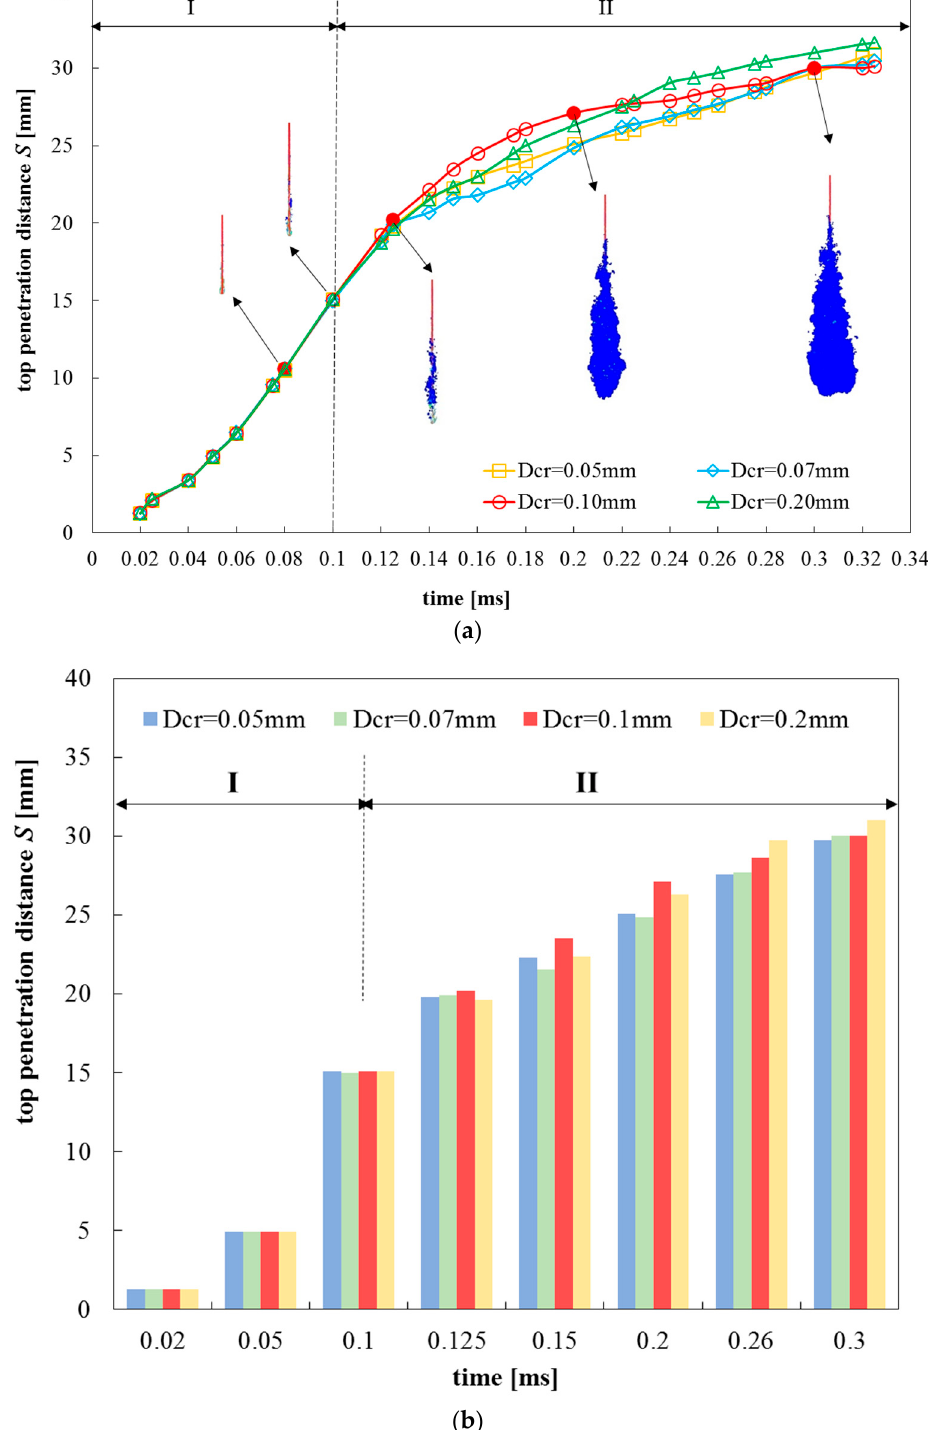
Figure 9. Diesel spray process. ( a ) Curves of the top penetration distance S for different transition criteria. ( b ) The effect of standard particle diameter on the top penetration distance S.